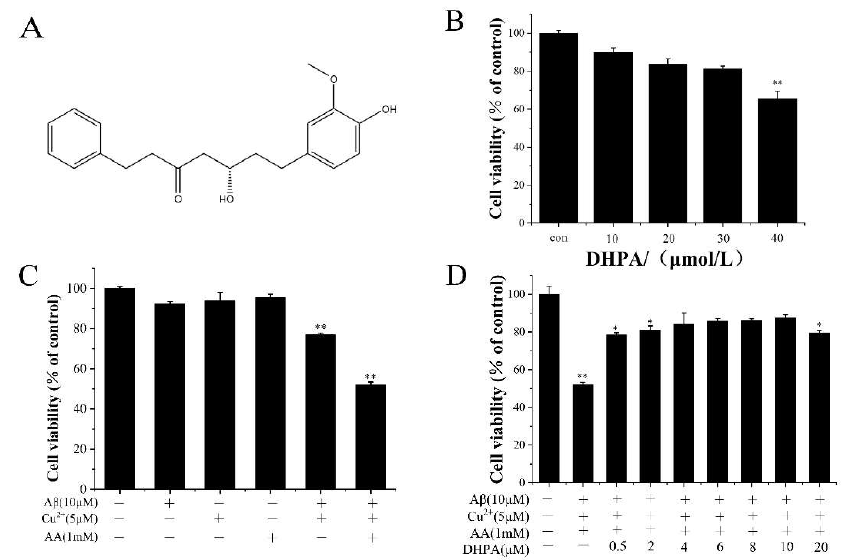
Figure 1. Molecular structure of DHPA ( A ); cell viability of different solution-treated SH-SY5Y cells ( B – D ). * p < 0.05 and ** p < 0.01 compared to the control group.